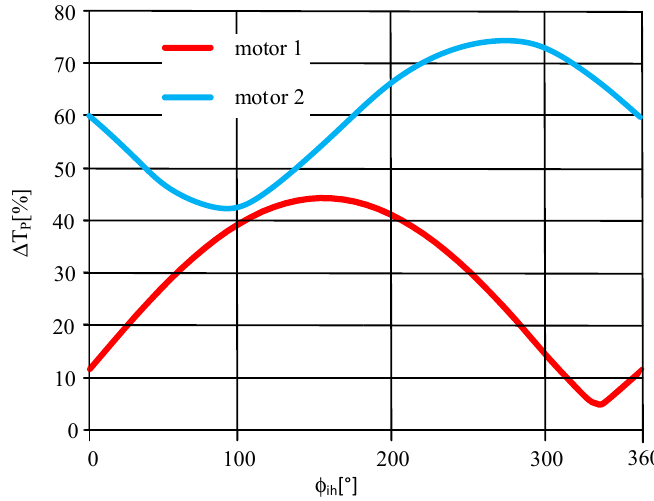
Figure 15. Pulsating torque component ∆ T p of the frequency described with (21), (22) versus the angle ϕ ih for ϕ sh = 0°, the load with a negligible moment of inertia and voltage fluctuation of the resonant frequency equal to f m =7 Hz and f m = 30 Hz for motor1, motor2, respectively.